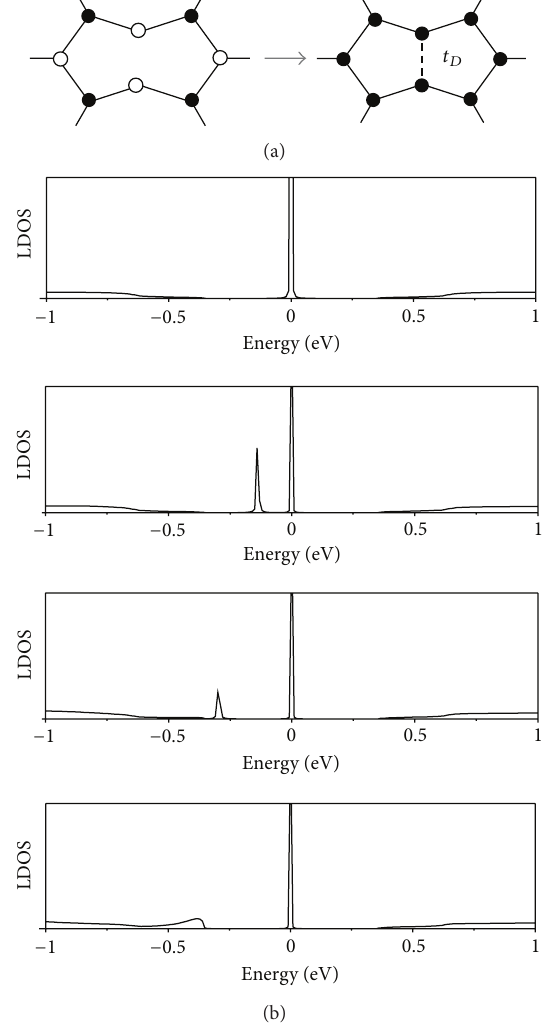
Figure 3: (a) A scheme showing the reconstruction of an 8N octagon into a pair of pentagons. (b) LDOS for the case of (8,0)/(14,0) junction with 8R octagon present and varying strengths of the bond between the two unsaturated nodes of the 8N octagon (hopping 𝑡 𝐷 at this bond varies from top to bottom: 0, 0.2 𝑡 , 0.5 𝑡 , 𝑡 ).